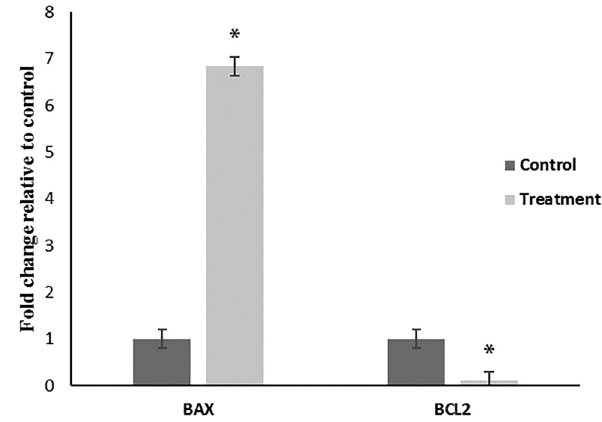
Figure 5: Gene expression ratio of Bcl - 2 and Bax in HEK - 293 cells exposed to ZnO - NPs compared to untreated control cells. HEK - 293 cells were treated with ZnO - NPs ( 60 µg/mL ) for 48 h. Expression of Bax and Bcl - 2 were considered as 1 in untreated control HEK - 293 cells and the level of genes after treatment with ZnO - NPs are re - presented as the fold change over the untreated